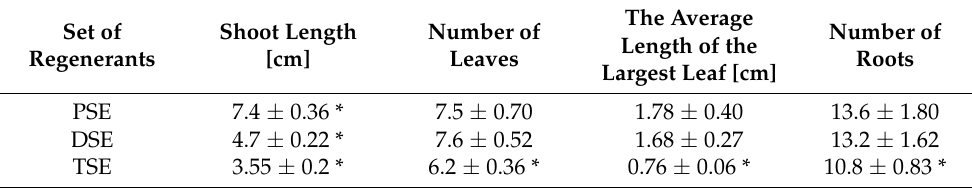
presented values are means (N = 15) ± SD, values marked with asterisk within groups are statistically different ( p < 0.05) from the